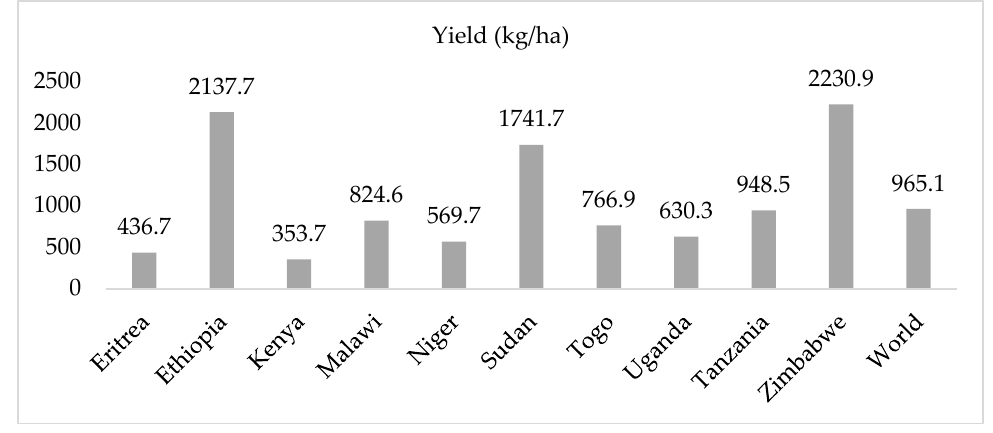
Figure 3. The productivity level of chickpea in SSA countries [14.